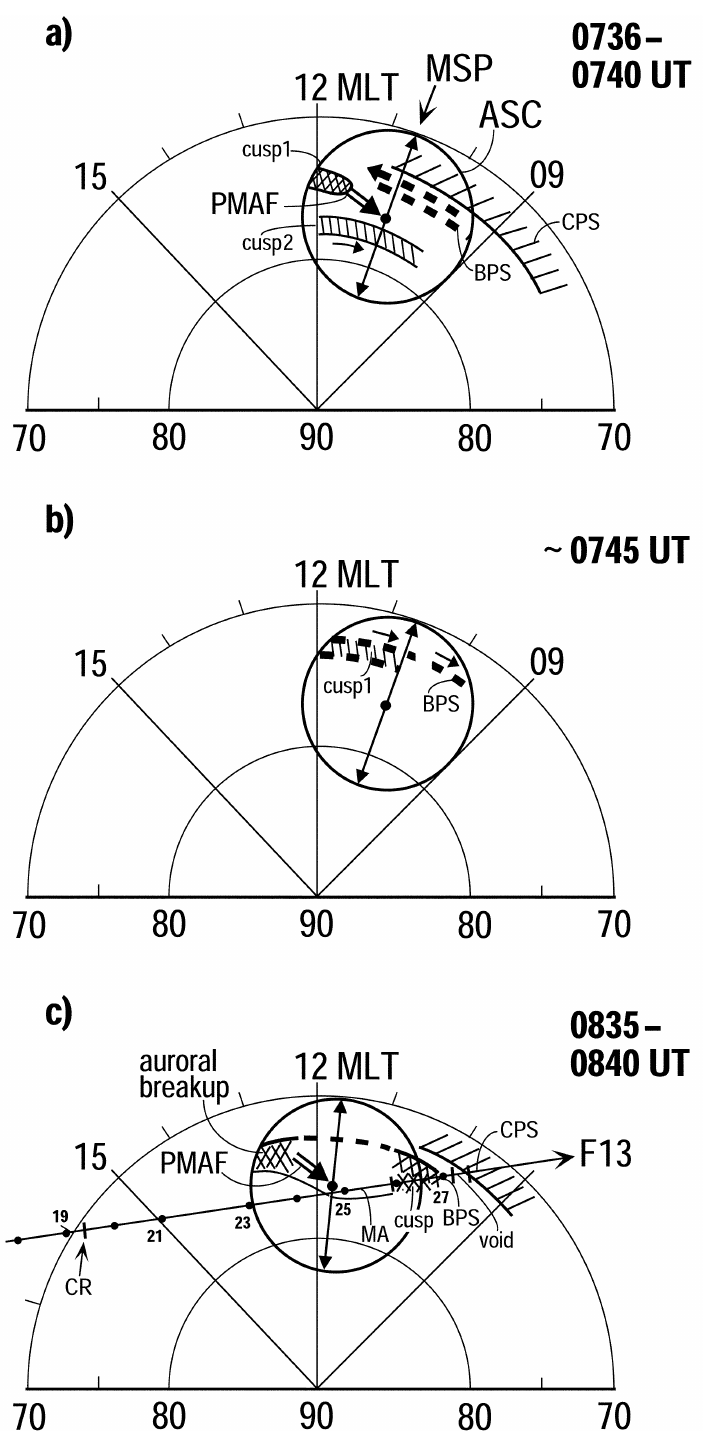
∼ 07:45 UT (middle panel), Figure 4 Fig. 4. Schematic overview of auroral observations during the intervals (a) 07:36–07:40 UT (upper panel), (b) and (c) 08:35–08:40 UT. The coordinate system is MLT/MLAT. Fields of view of the all-sky camera and the MSP (at 630.0nm) in Ny ˚Alesund are marked by the circle and the double-arrowed meridional line, respectively. The direction of motion of auroral structures is marked by arrows. The track of satellite DMSP F13 during the interval 08:18–08:30 UT is shown in panel (c). A “gap” in the auroral emission in the midday sector is marked by dashed line in the same